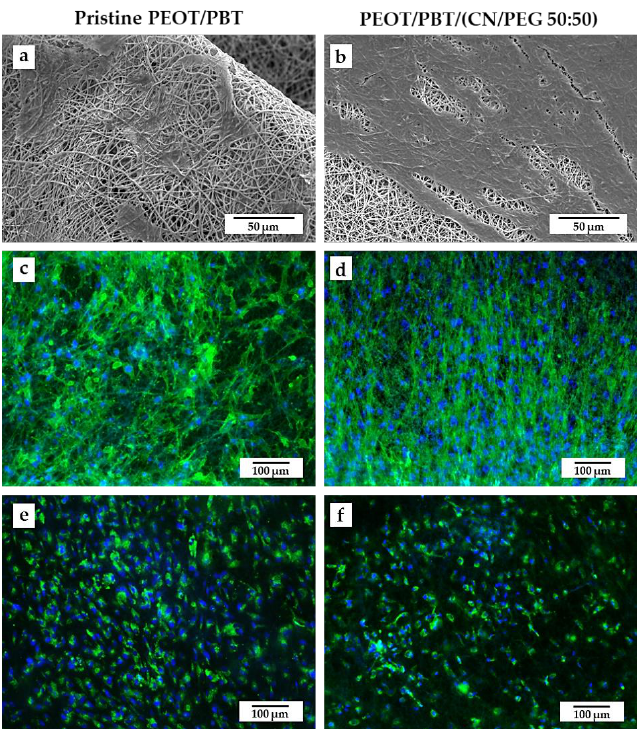
Figure 6. SEM micrographs of hMSCs differentiated into fibroblasts on ( a , c , e ) PEOT/PBT and ( b , d , f ) PEOT/PBT/(CN/PEG 50:50) scaffolds: ( a , b ) SEM micrographs imaging elongated cells adhered on the surface of the fiber meshes. Scale bar: 50 μm, high voltage (HV) 10 kV, magnification 1600×; ( c , d ) fluorescence micrographs revealing f- actin with phalloidin (green) and cell nuclei with DAPI (blue) staining; and fluorescence micrographs revealing collagen type I (green) immunofluores- cence and DAPI (blue) staining. Scale bar: 100 µ m, original magnification 100 ×